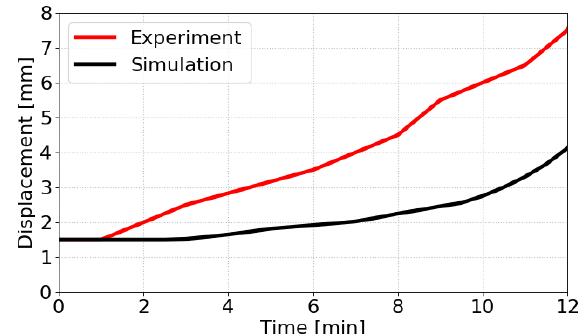
Figure 22. Comparison of the experimental and calculated displacements for beam #1 until reaching the temperature of 600 ◦